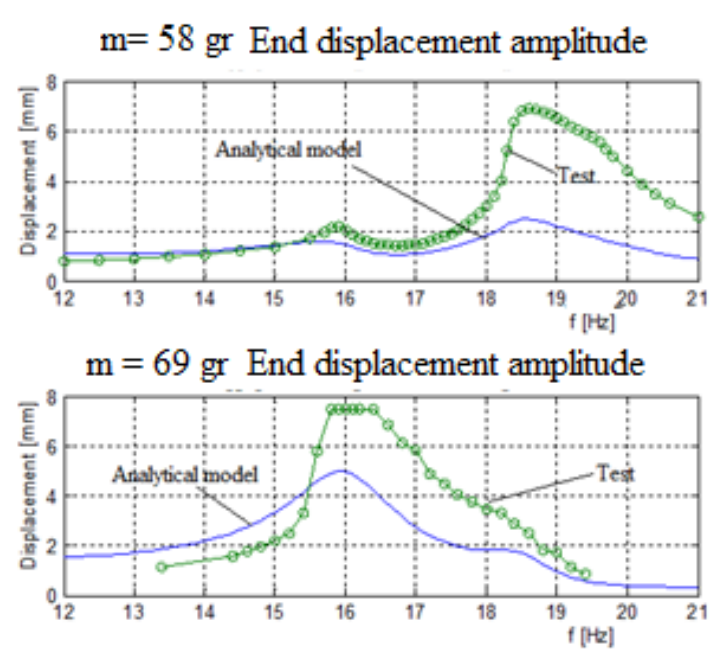
Figure 11. Three bimorphs system displacements (parallel electrical connection)—experimental results vs. analytical predictions.